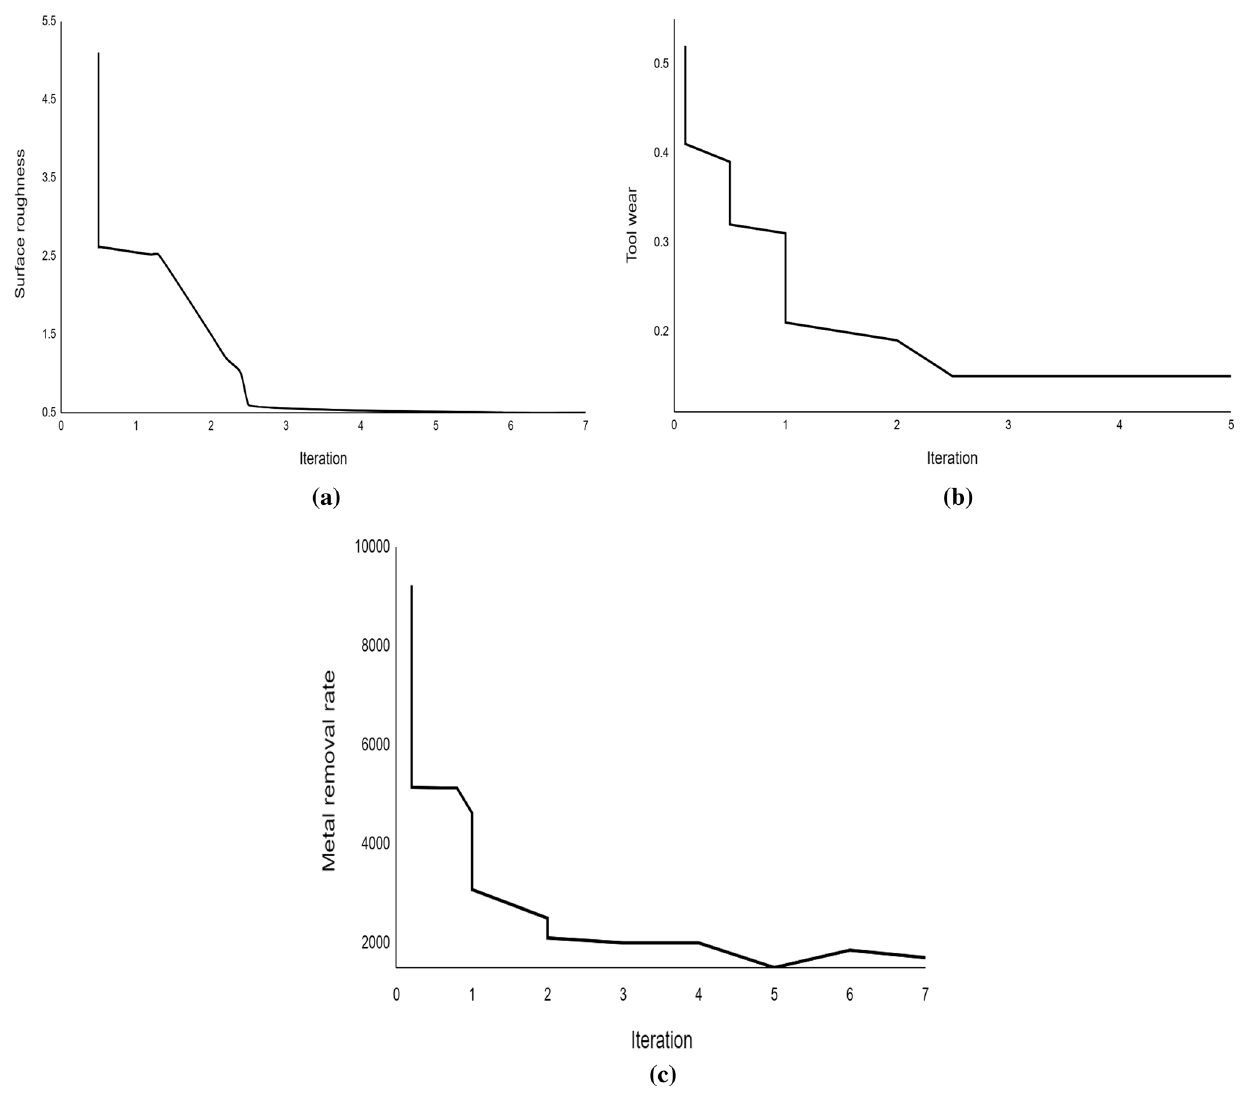
Fig. 14 Convergence graph for ( a ) surface roughness, ( b ) tool wear, and ( c ) MRR